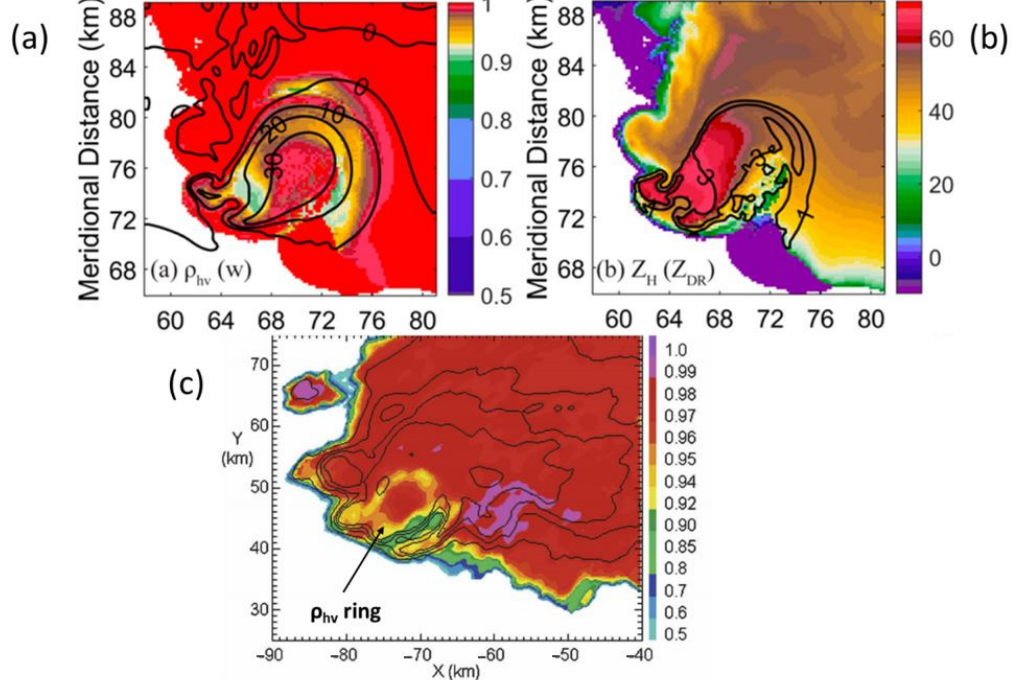
Figure 11. The ρ hv and Z DR rings simulated in a supercell storm at ~4.6 km above ground level (AGL), as shown by ( a ) ρ hv (colors) and w (contoured every 10 m s − 1 ), ( b ) Z (dBZ; colors) and Z DR (dB; contoured every 1 dB), and ( c ) a typical midlevel ρ hv ring observed in the supercell. The polarimetric variables are calculated for the X band. Adapted from Snyder et al. [65,66] and Kumjian and Ryzhkov [89]. Used with permission from American Meteorological Society.